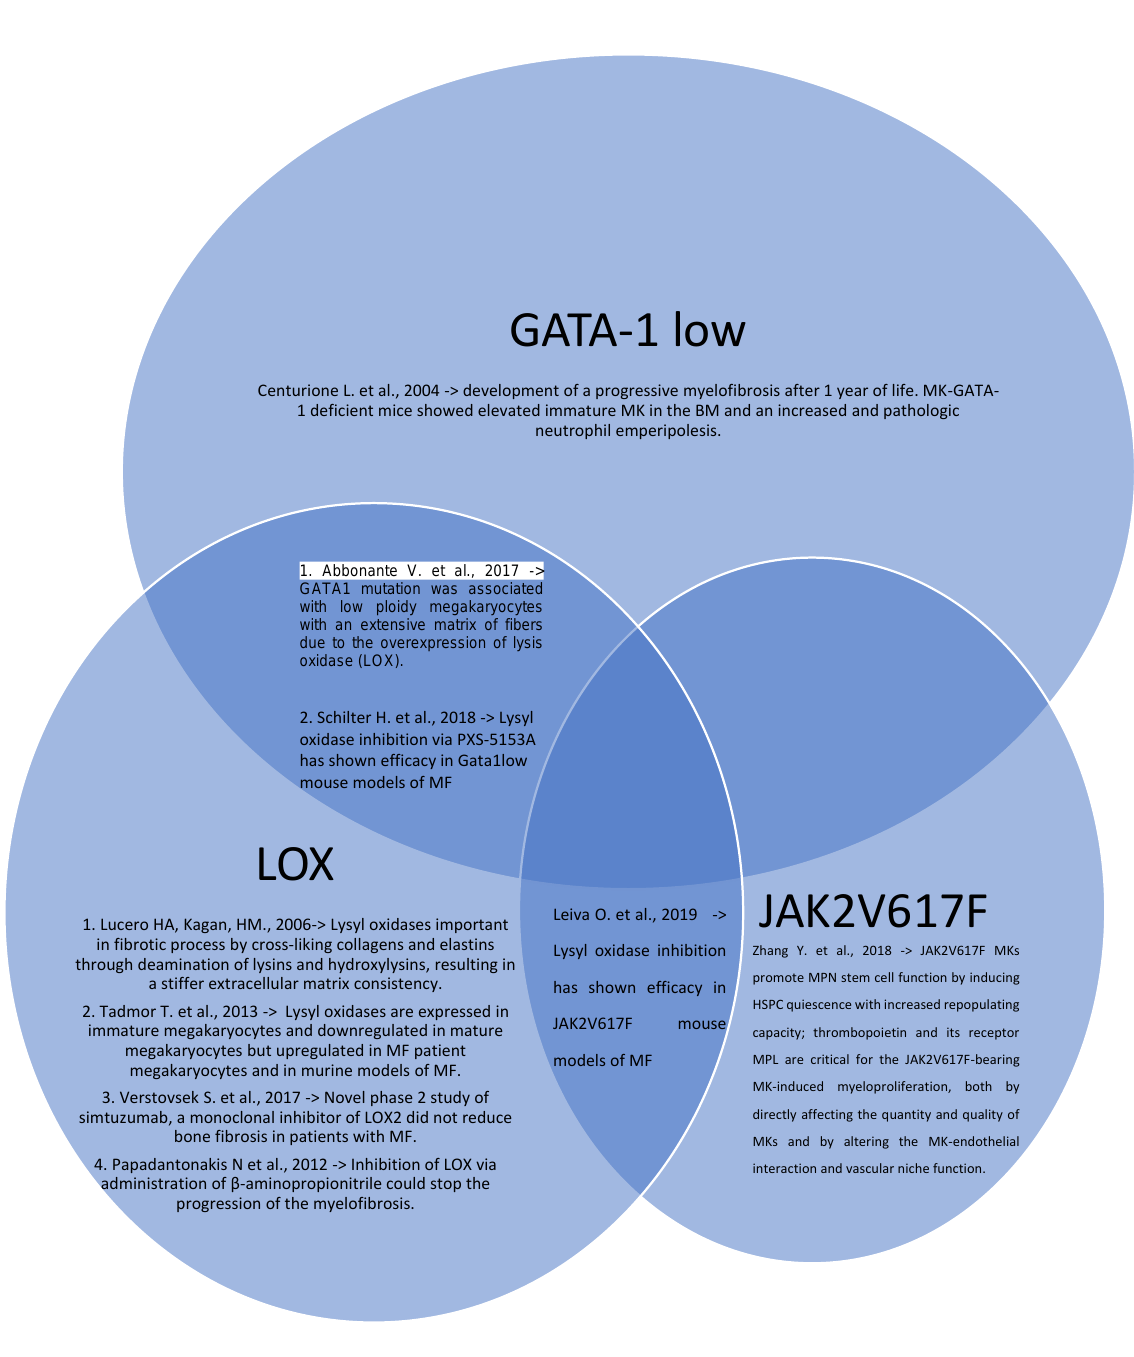
Figure 1. Venn diagram of MPNs in vivo models with their intercorrelations and their main results (Centurione L. et al. [15], Abbonante V. et al. [16], Lucero HA, Kagan, HM. [17], Tadmor T. et al. [18], Schilter H. et al. [19], Leiva O. et al. [20], Verstovsek S. et al. [21], Papadantonakis N et al. [22], Zhang Y. et al.